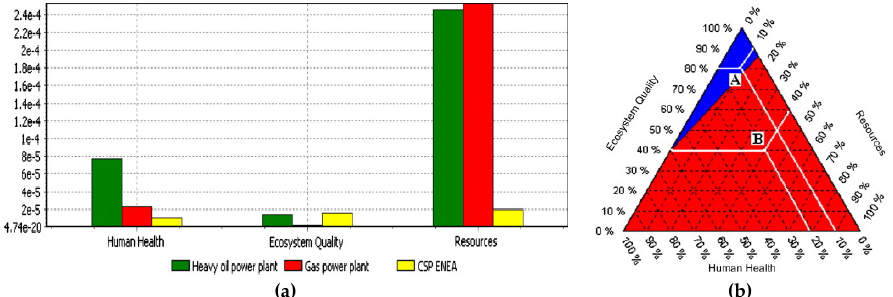
Figure 3. Comparison of the global impact of CSP plant vs. gas power plant: ( a ) damage-oriented approach and ( b ) mixing triangle approach [77]. (Reprint with permission [77]; 2019,